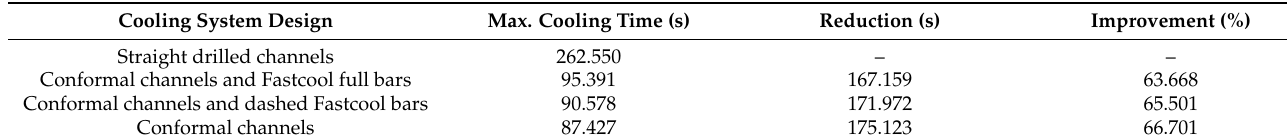
Table 10. Maximum cooling time parameters for each cooling system design.